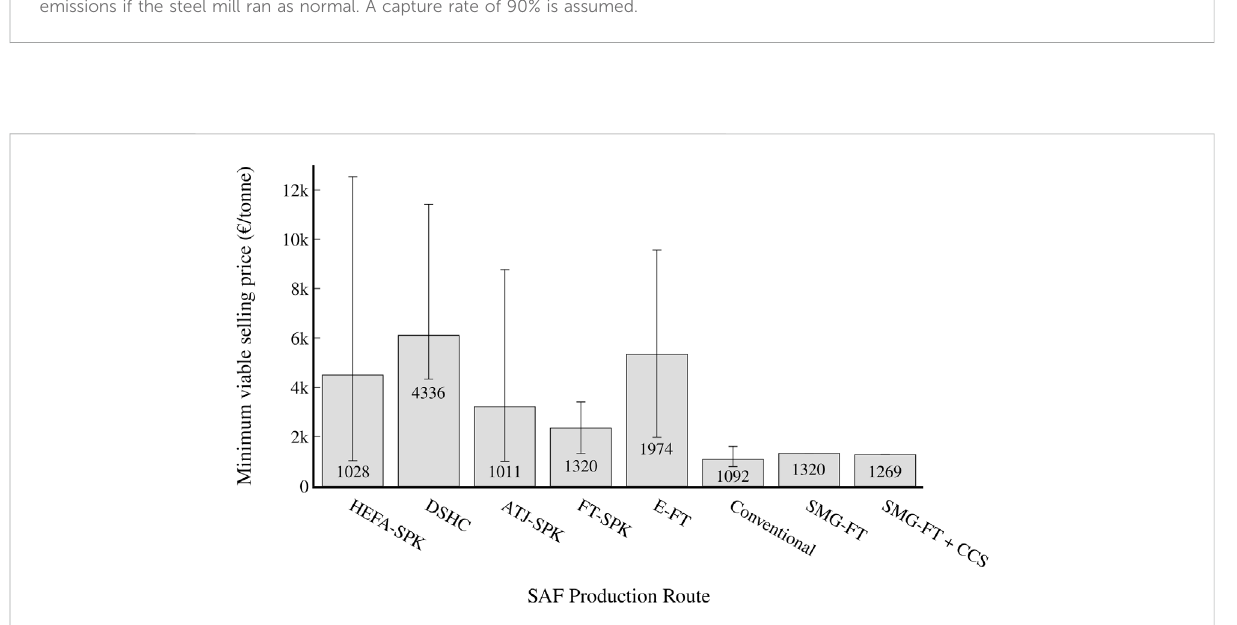
FIGURE 12 MVSP (production cost) taking into account a CO 2 tax of 130 € /tonne of the various SAF cost and emissions benchmarks (see section 3.1) and conventional aviation fuel. The grey bar represents the median cost and emissions found for each process route among studies, while the error bars correspond to the lowest and highest cost and emissions found for each process route. The text states the lowest calculated cost for each SAF production